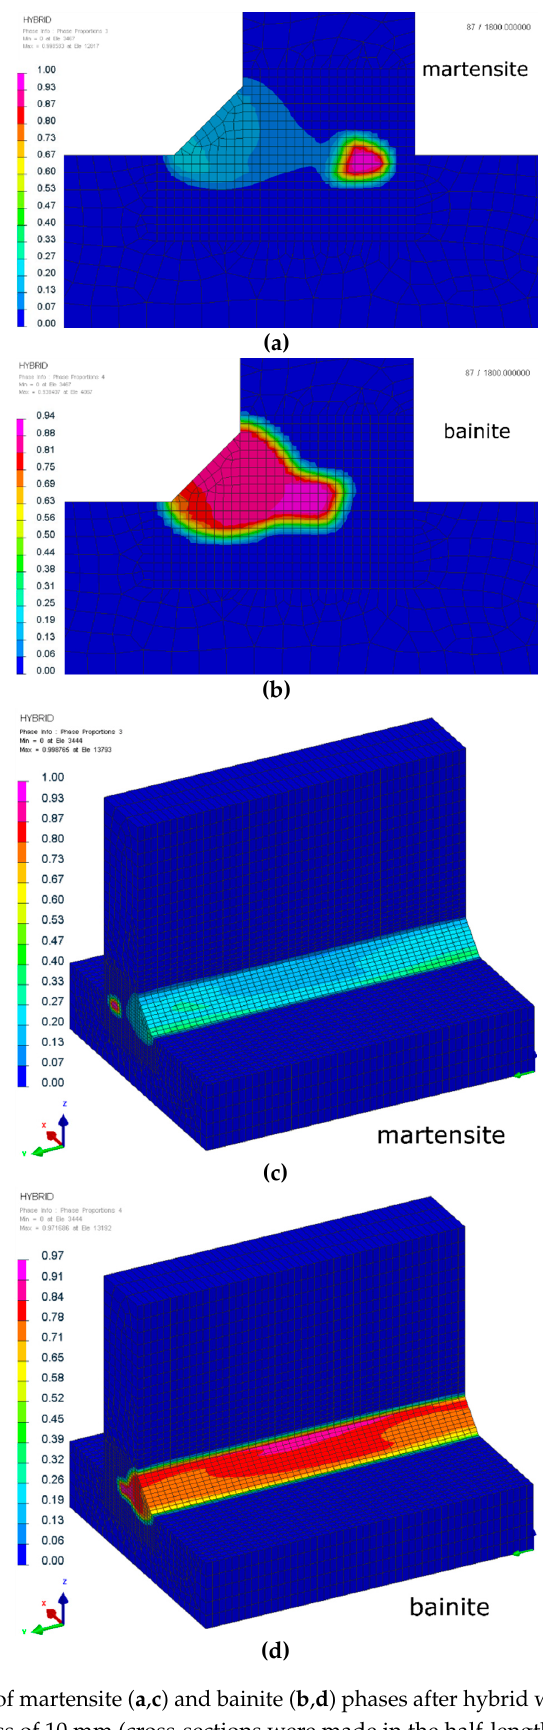
Figure 7. Distribution of martensite (a,c) and bainite (b,d) phases after hybrid welding of S700MC steel T-joints with a thickness of 10 mm (cross-sections were made in the half-length of the joint). Using a coupled thermo-metallurgical analysis gave us the possibility of hardness distribution calculations. They were calculated based on the metallurgical phases, the chemical composition, and the cooling speed rates. It is visible that the hardness values confirmed the martensite and bainite distribution presented above (Figure 8). Calculated results were also compared with the real hardness measurements, as shown in Table 6. Table 6. Comparison of measured and calculated hardness values in laser and hybrid welding of S700MC steel T-joints with a thickness of 10 mm. HAZ—heat-affected zone; FEM—finite element modeling.